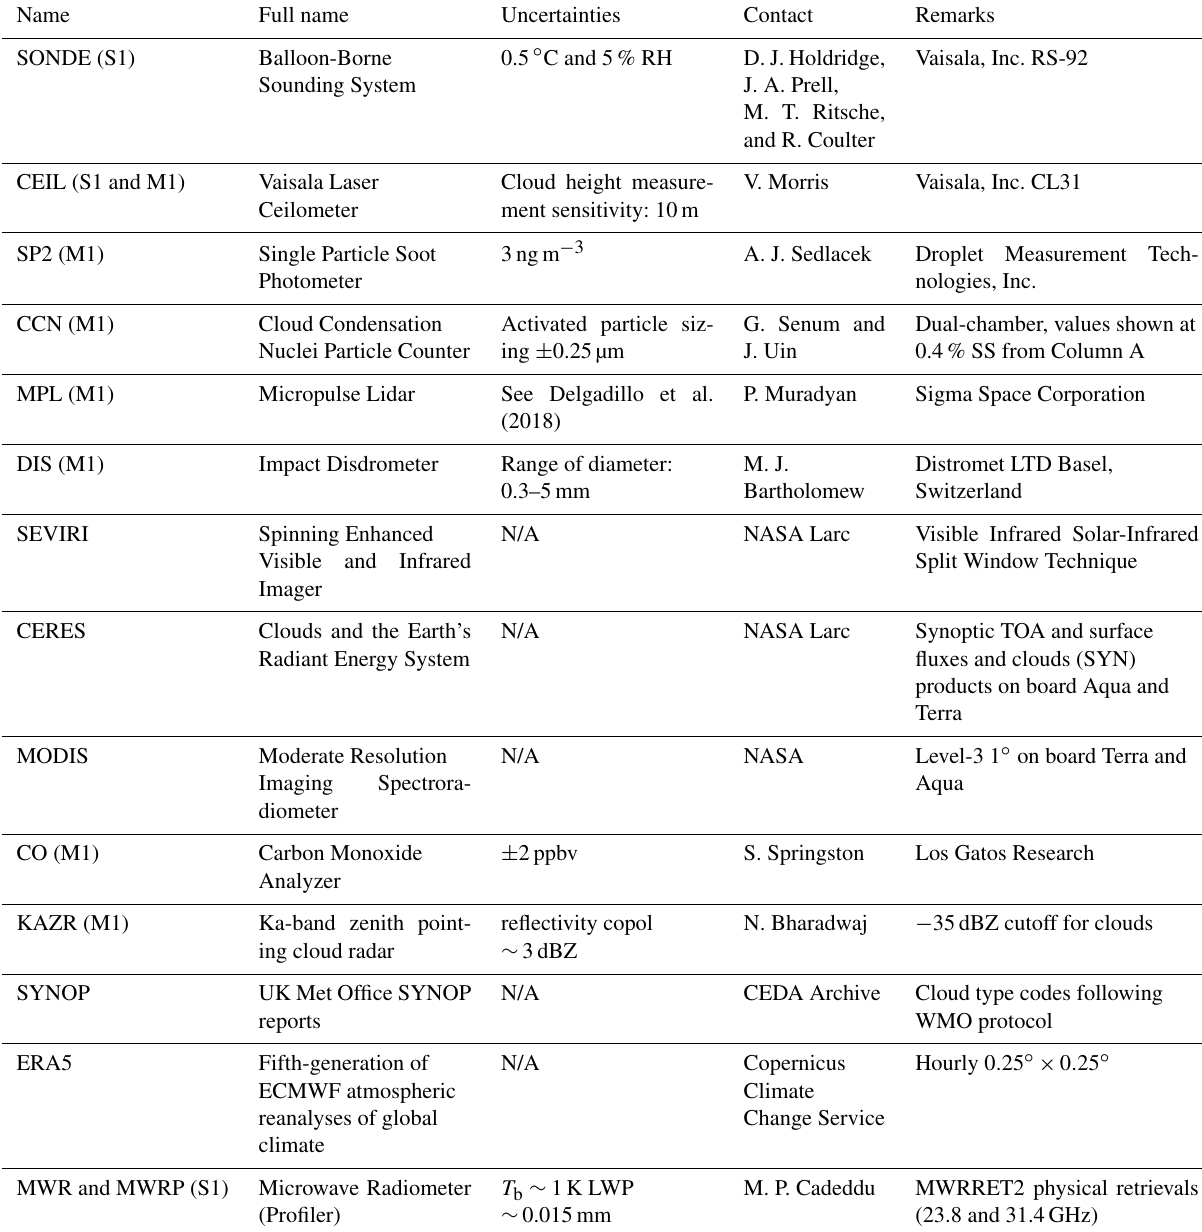
Table 1. Full list of datasets used in this paper with source/contact and remarks. The airport site is S1 and the AMF1 site is M1. For more information on accessability see statement at the end of the